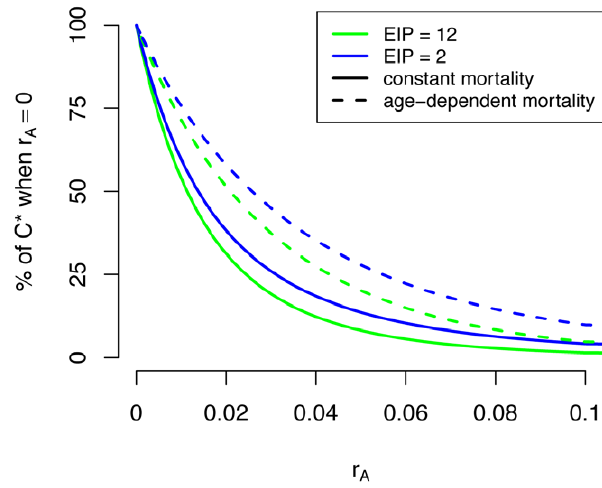
Figure 5. Sensitivity of vectorial capacity to mosquito survival. The above figure shows a sensitivity analysis of scaled vectorial capacity ( C* ), as a percentage of its baseline value ( i.e. when r A =0), to increasing levels of mosquito mortality from anti-vectorial interventions ( r A . 0). Note that the age dependent models are less sensitive to reductions in survival in that they require greater r A to achieve the same percentage reduction in C* . Additionally, shorter extrinsic incubation periods (EIP) make C* in age dependent models slightly less sensitive to r A .